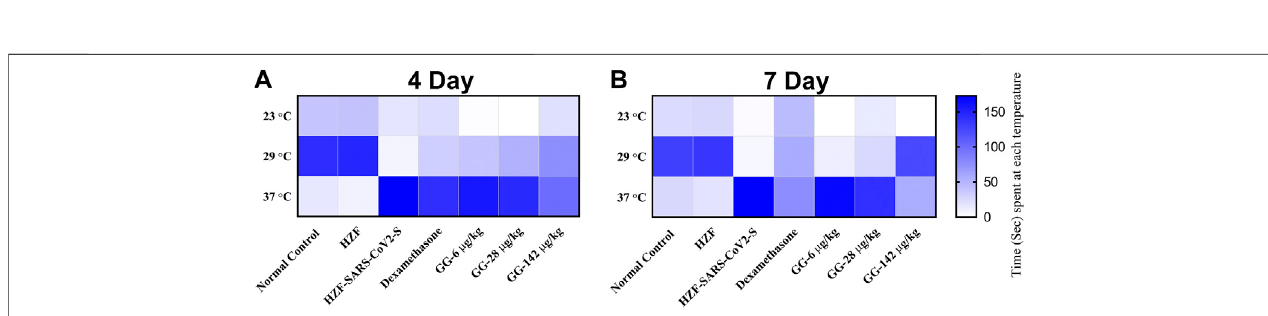
FIGURE 8 | Heat map showing changes to body temperature of zebra fi sh as assessed by behavioral fever. The mean time spent by individual fi sh in each of the three temperature chambers (23, 29, and 37 ° C), is shown. Increase in color intensity shows longer time spent at a particular temperature.